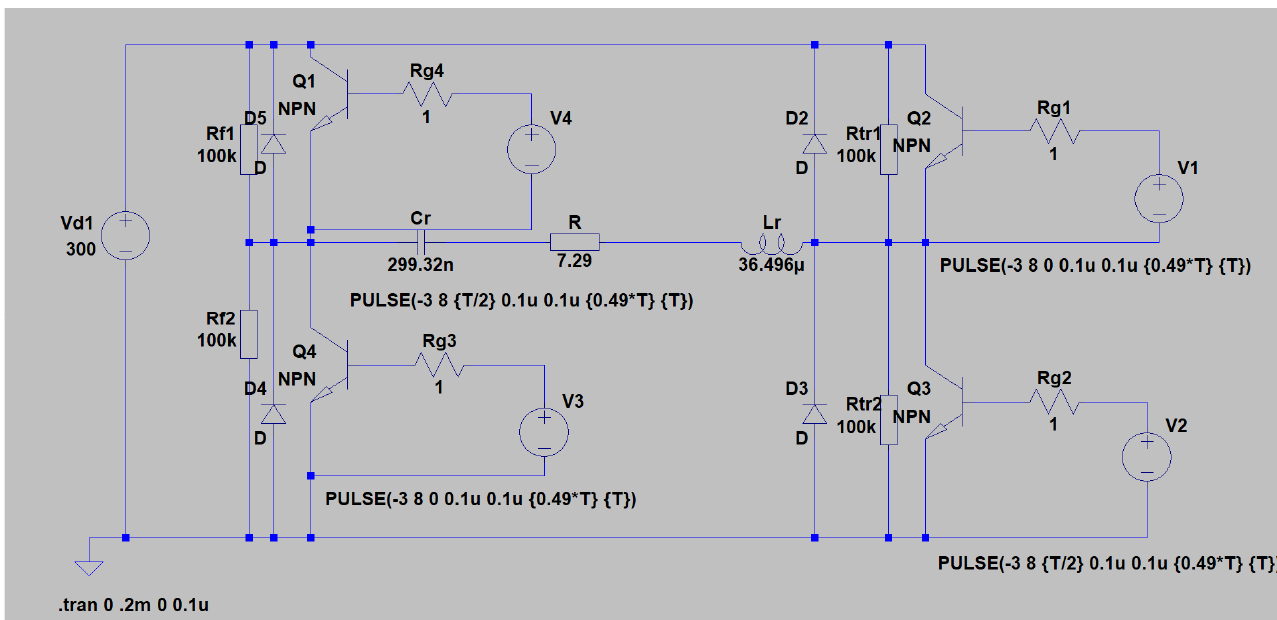
Figure A2. Simulation model of a series resonant inverter without reverse diodes. Figure A3 shows the simulation model of a series resonant inverter with reverse diodes.